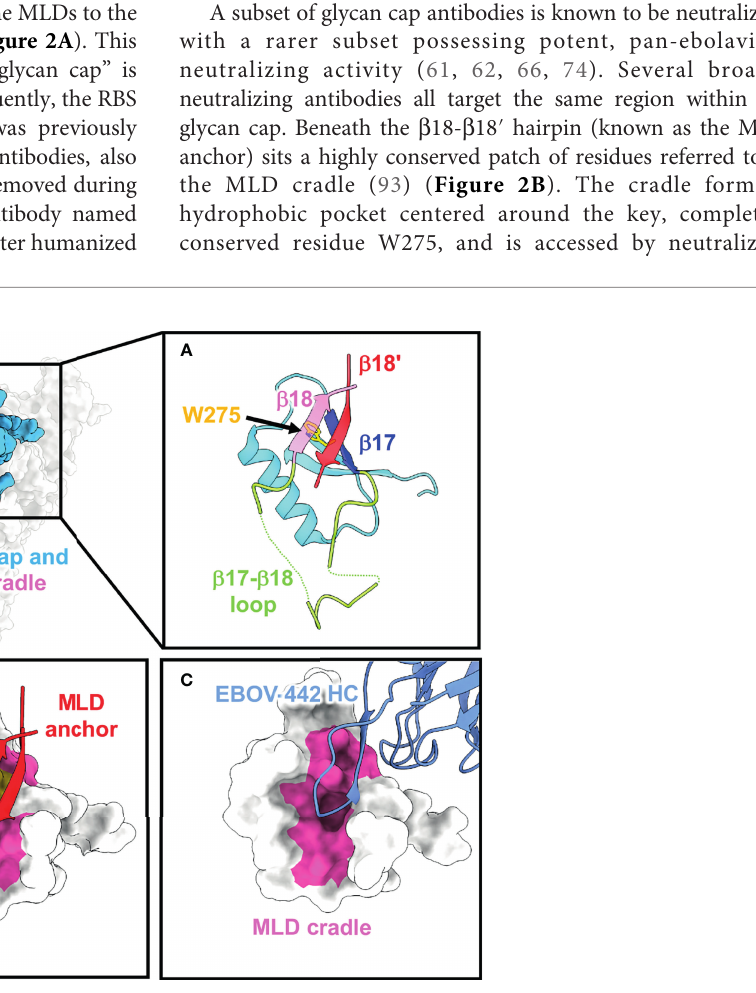
FIGURE 2 | The glycan cap and MLD cradle subdomain. (A) The glycan cap (cyan) within the ebolavirus GP consists of globular region that contains several N- linked glycosylation sites, a loosely structured loop (green) between b 17 (blue) and b 18 (pink) that interacts with the base of the fusion loop in GP2. The mucin-like domains are anchored to the glycan cap via b 18 and b 18 ′ (red) (PDBID: 5JQ3) and the cradle is subdivided by the critical and conserved residue W275 (yellow). (B) The MLD anchor (red), made of b 18 and b 18 ′ , shields the MLD cradle (pink) and sits over W275. (C) The MLD cradle is accessed by broadly neutralizing antibodies through structural mimicry and displacement of the MLD anchor by long CDR loops. Shown is an example from the structure of the broadly neutralizing antibody EBOV-442 (PDBID: